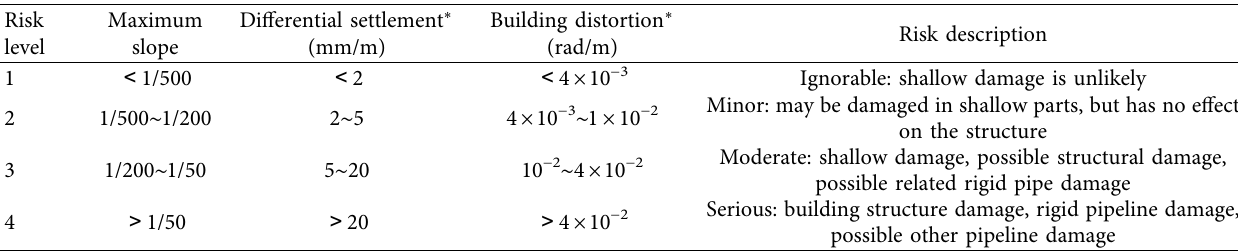
Table 4: Building damage grade evaluation